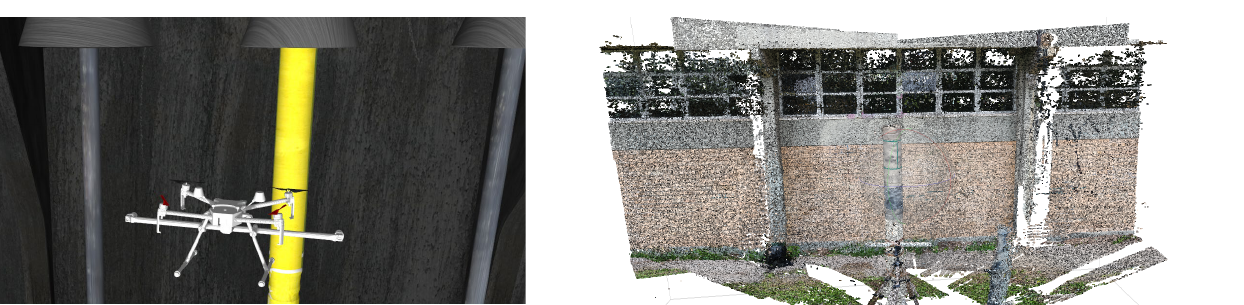
Figure 15. Practical pipe and background scene measurement result using trajectory “C” in real environment. Acquisition distance was set to about 5 m.